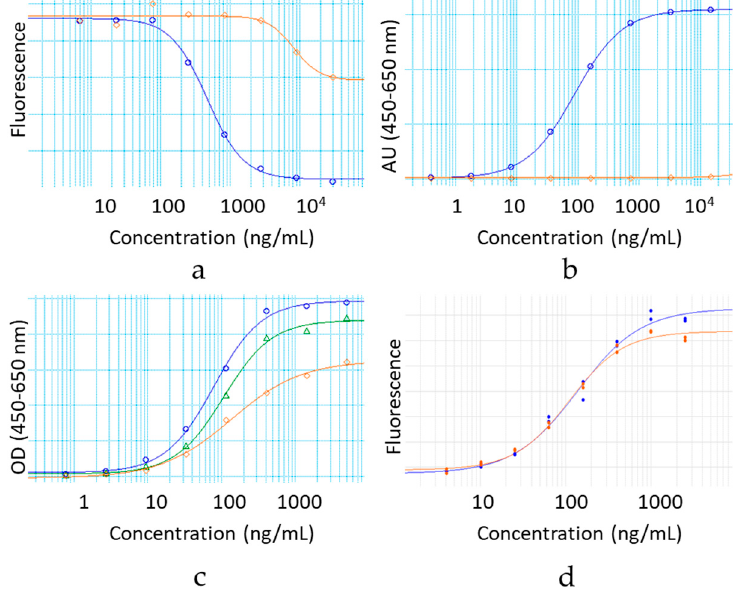
Figure 6. Binding of hinge deleted IgG1 (orange dilution curves) and its corresponding full-length control mAb (blue dilution curves) to ( a ) Fc γ RI by competitive AlphaScreen ® assay, ( b ) Fc γ RIIIa V158 by binding ELISA, ( c ) FcRn by binding ELISA. Incorporation of point mutations in the Fc of the hinge deleted IgG1 (green dilution series) almost rescues binding to the level of the full-length control. ( d ) Engagement of the gp120 target antigen by a HEK290 cell-based ELISA reflective of the mAb mode of action.